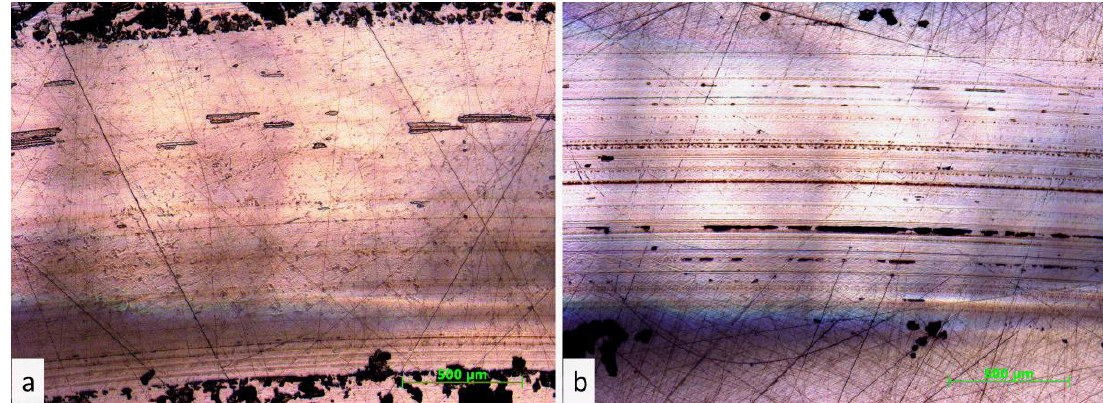
Figure 9. Optical images of steel counterbody surfaces after 30 min of dry sliding contact with. unfilled FEP ( a ) and FEP/1.25 wt.% CB/1.25 wt.% QC Al 73 Cu 11 Cr 16 ( b ).